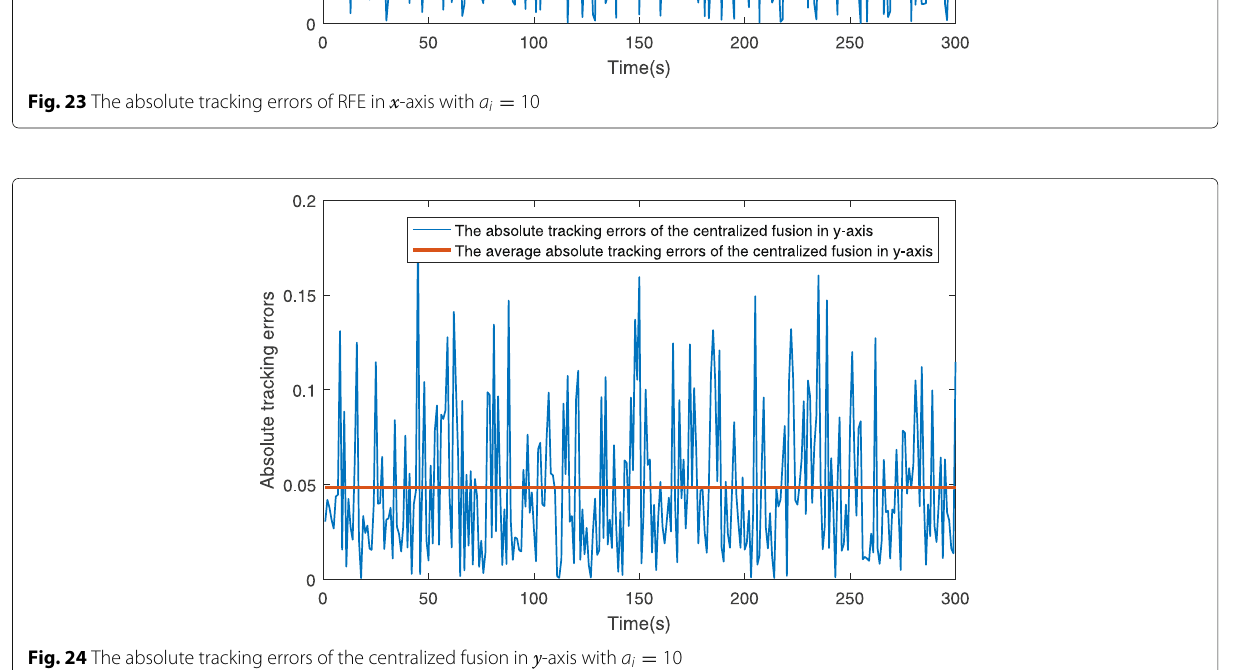
Fig. 24 The absolute tracking errors of the centralized fusion in y -axis with a i = 10